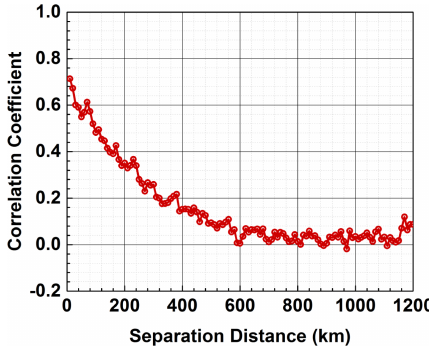
Figure 2. Correlation coefficients (averaged over 10km) as a func- tion of the separation distances between two surface-level monitor- ing stations using the Hollingsworth–Lönnberg